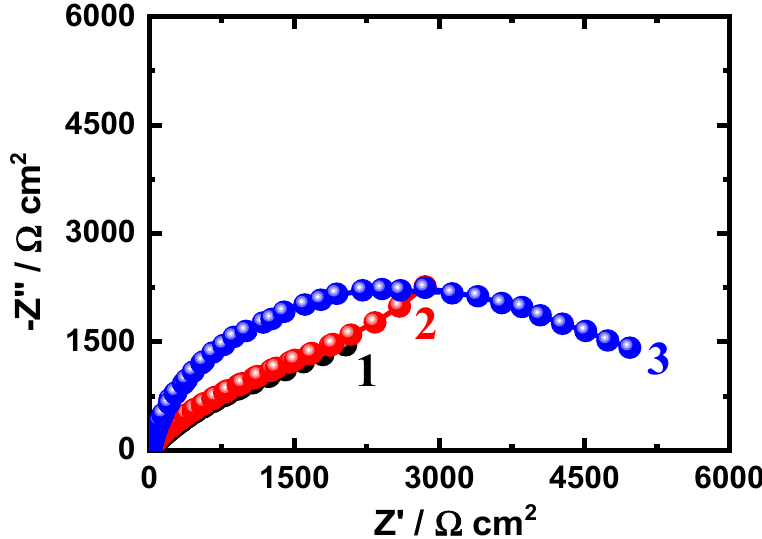
Figure 7. Nyquist plots obtained for (1) first Al-SiC nanocomposite, (2) second Al-SiC nanocomposite and (3) third Al-SiC nanocomposite after their immersion in 3.5% NaCl solutions for 24 h.